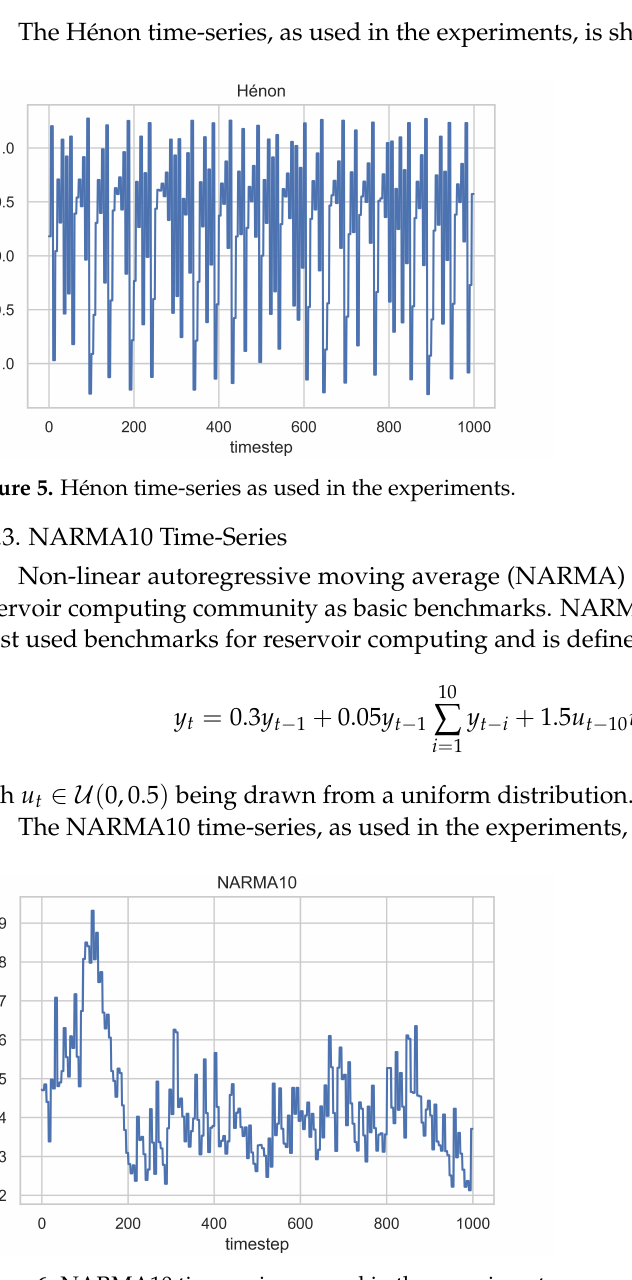
Figure 6. NARMA10 time-series as used in the